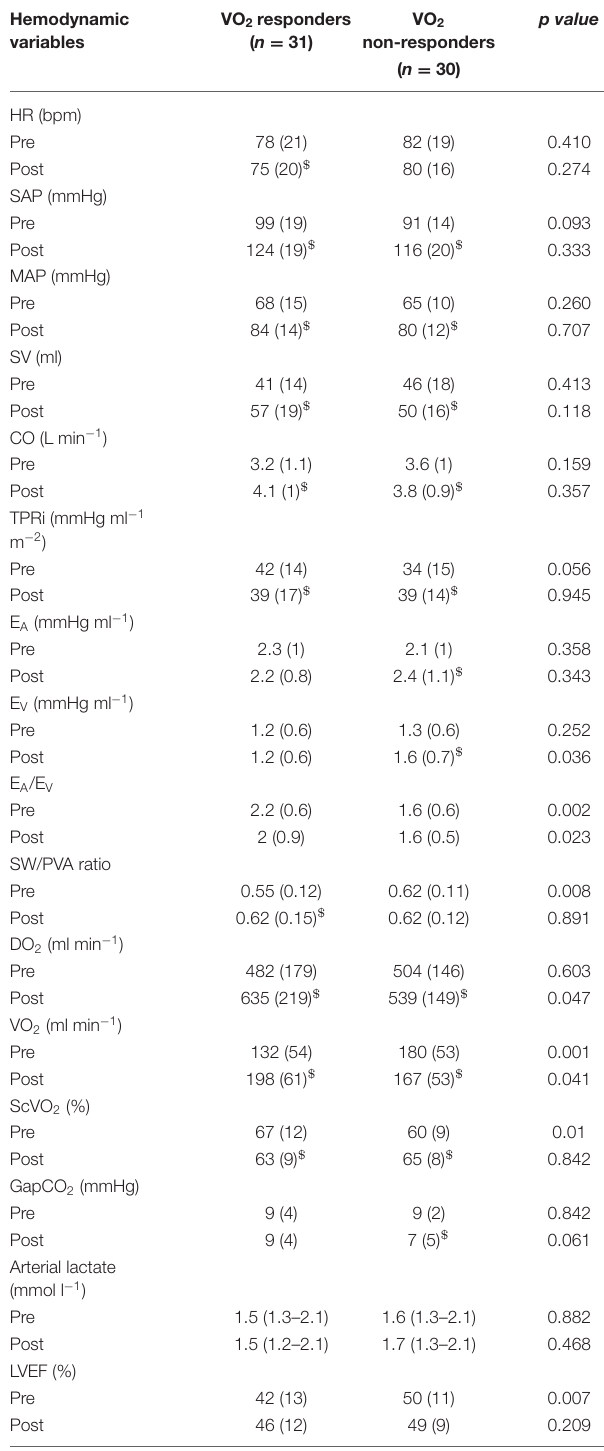
TABLE 2 | Comparison of haemodynamic parameters in VO 2 responders and VO 2 non-responders. Values are expressed as the mean (SD) or the median (interquartile range). Hemodynamic